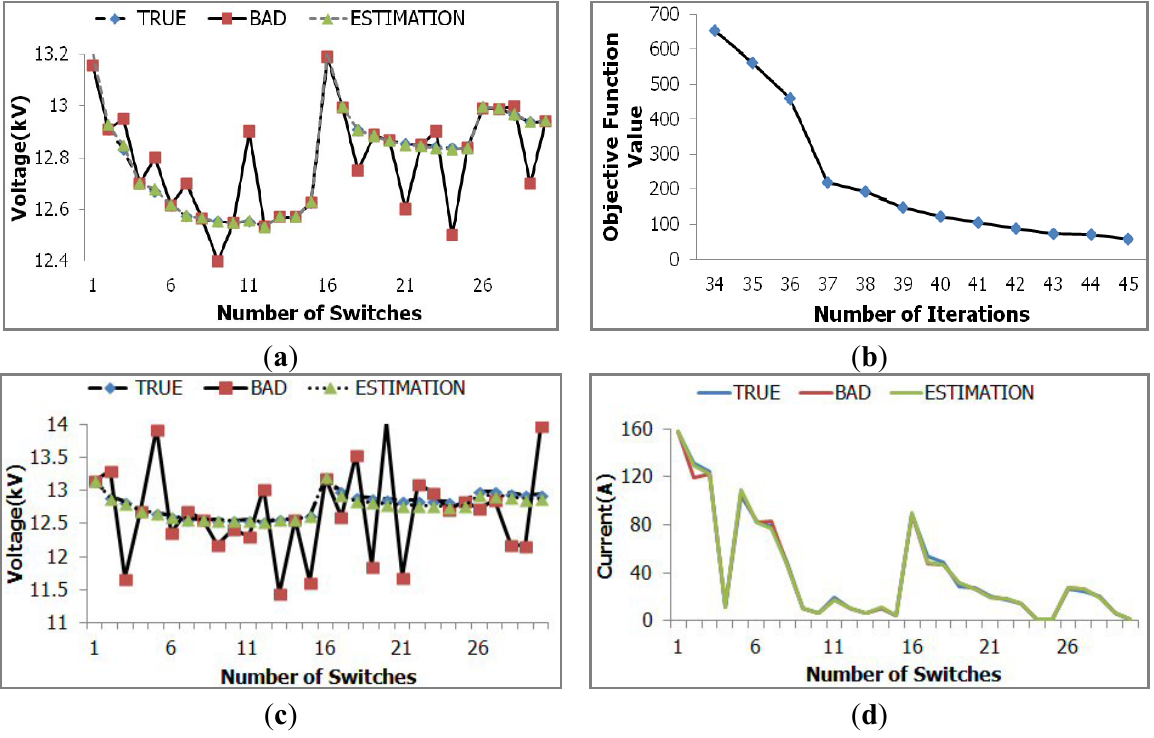
Figure 12. Results of the DSE functional test: ( a ) result of bad voltage data test for Case 1; ( b ) changes of object value for Case 1; ( c ) result of bad voltage data test for Case 8 and ( d ) result of bad current data test for Case